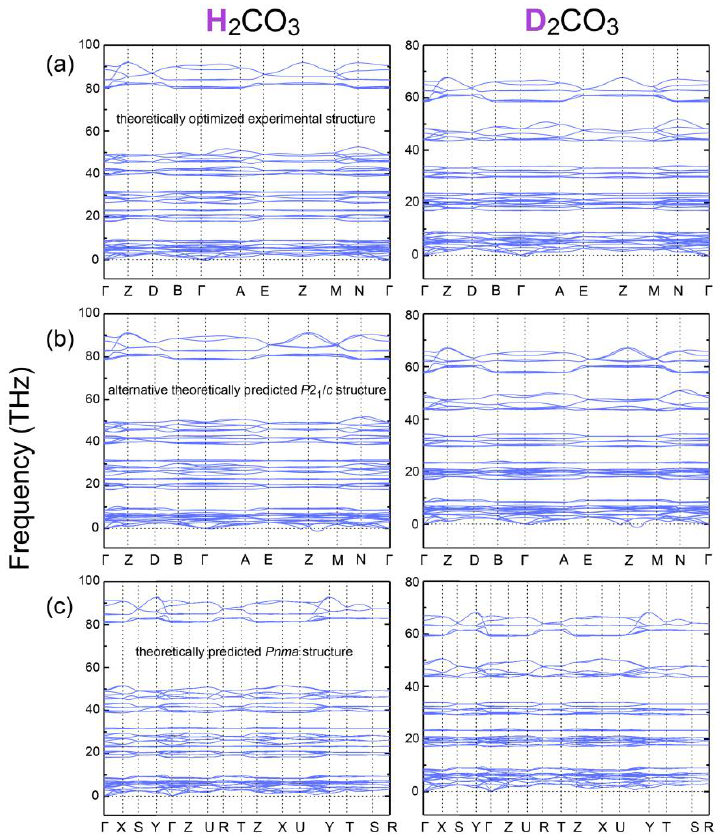
Figure A2. Phonon band structures of carbonic acid at a pressure of 2 GPa. Shown are those of ( a ) the theoretically optimized experimental structure based on a 3 × 3 × 3 supercell with 648 atoms, ( b ) the alternative theoretically predicted P 2 1 / c structure based on a 3 × 3 × 3 supercell with 648 atoms, and ( c ) the theoretically predicted Pnma structure based on a 2 × 3 × 2 supercell with 288 atoms.